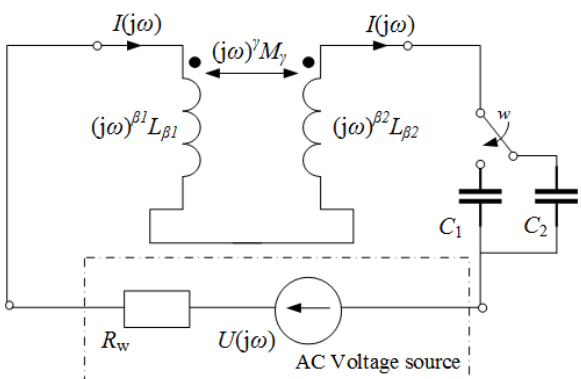
Fig. 1. The equivalent circuit for the fractional-order parameters identification by resonance